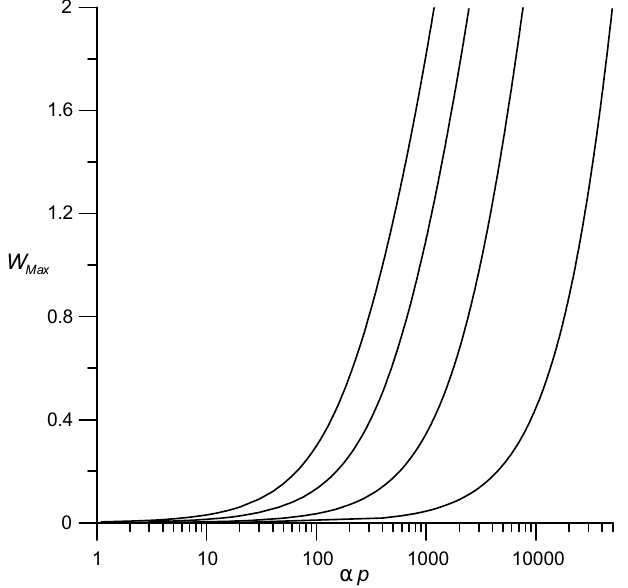
Fig. 12. Variation of the maximum nondimensional deflection W Max with the applied nondimensional load αp for hinged-clamped plates of inner radii b = 0 . 1 , 0 . 3 , 0 . 5 , and 0 . 7 .